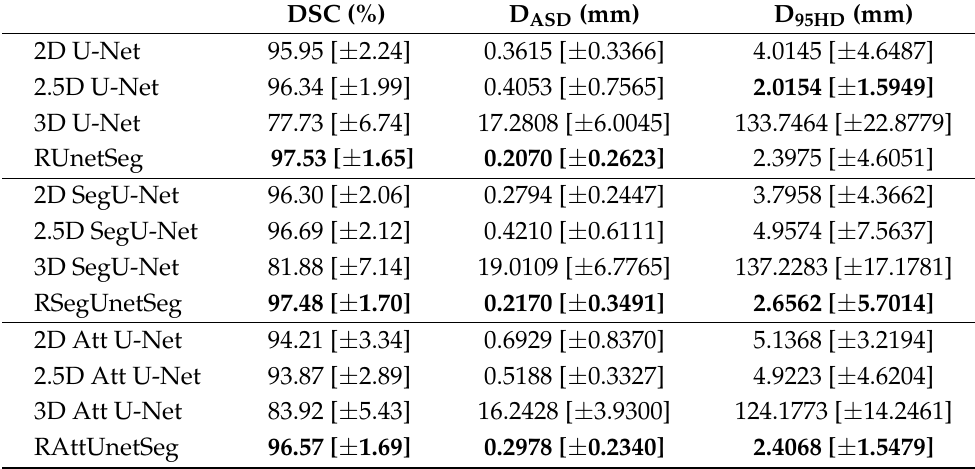
Table 1. Quantitative comparison of segmentation performance in the UMCG dataset between the proposed RCNNSeg and the classic EDCNNs. The values in the square brackets indicate the standard deviation of the corresponding measurements. We mark in bold the best performance in each